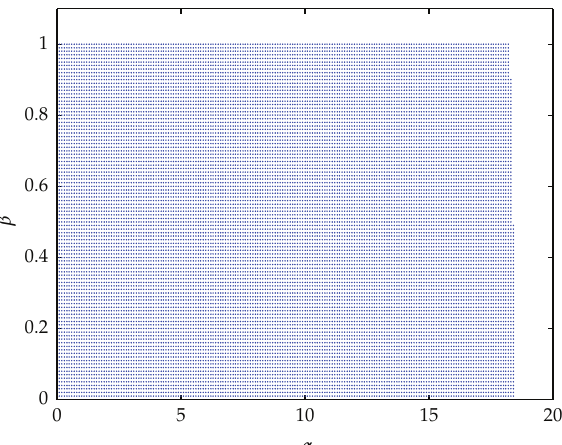
Figure 13: Stability region of the Nash equilibrium point in the plane (cid:2) α,β (cid:3) .